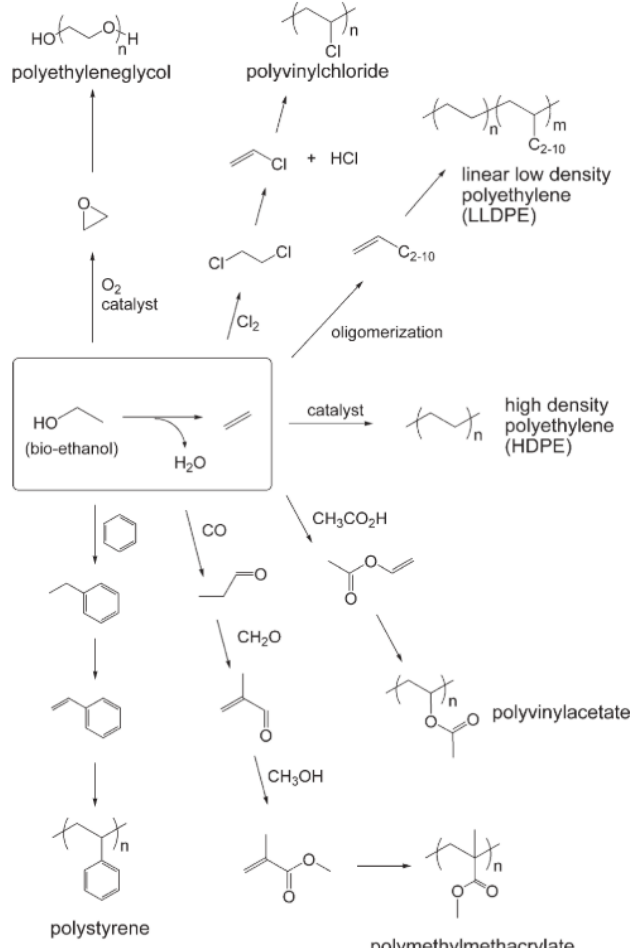
Figure 18. Chemical pathways for manufacture of alkene monomers and polymers from ethanol. Reproduced with permission from Robert T. Mathers, Journal of Polymer Science Part A: Polymer Chemistry; published by John Wiley and Sons, 2012 [388].